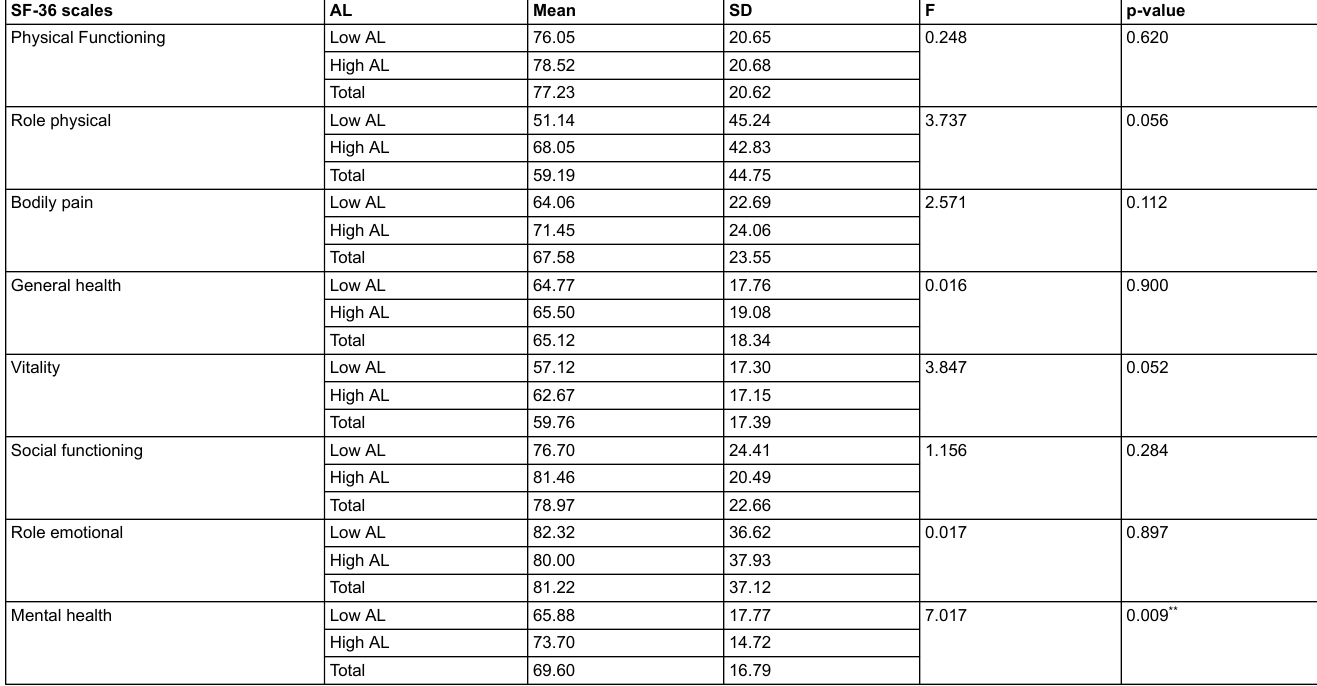
Table 3: MANCOVA presenting the influence of allostatic load on health-related quality of life. SF-36 scales